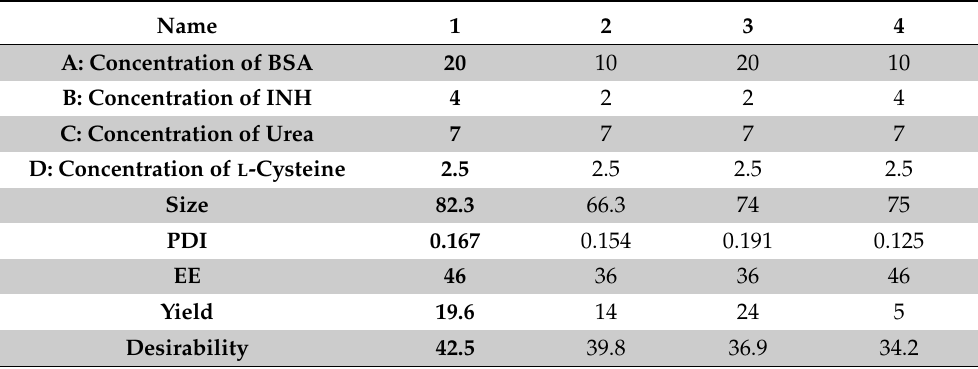
Table 8. Optimum solutions for BSA-INH NP synthesis.